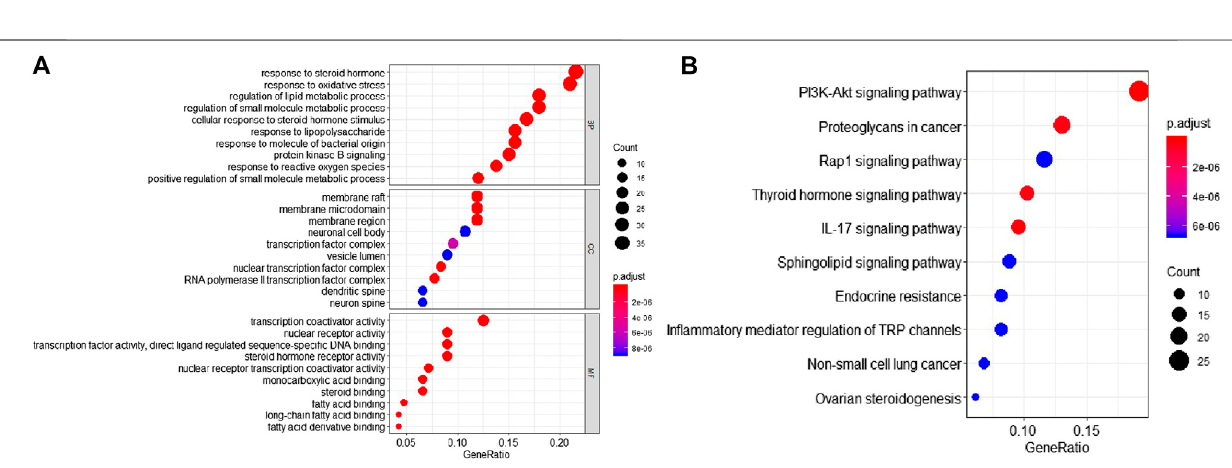
FIGURE 4 | Bioinformatics analysis of drug-disease intersection proteins (A) GO annotations (B) KEGG annotation.